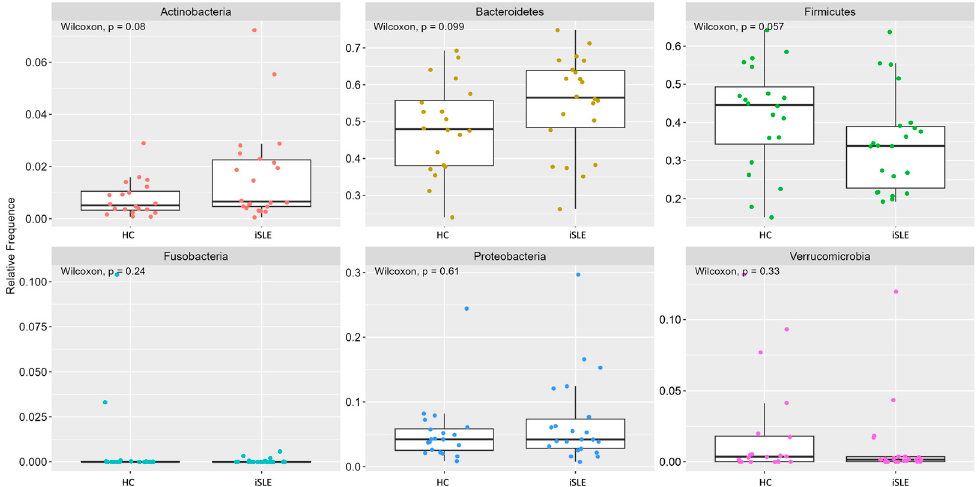
Figure 1. Relative abundance (%) of intestinal bacterial phyla in healthy control (HC; n = 20) versus inactive systemic lupus erythematosus group (iSLE; n = 22). Statistical significance p < 0.05.